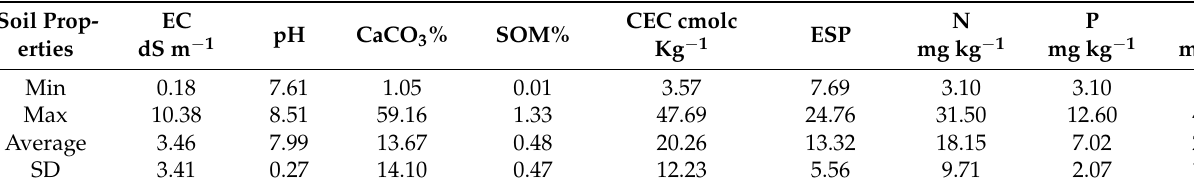
Table 2. Statistics of some mean weighted soil properties.